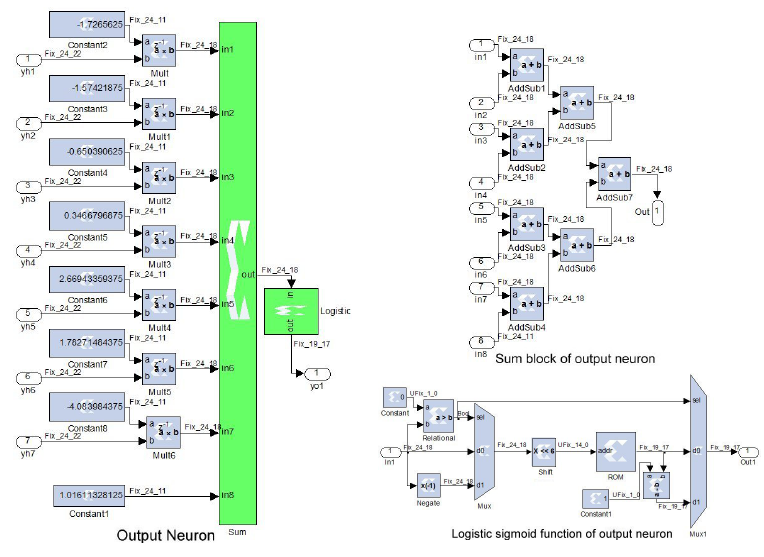
Figure 7. Implementation of the output neuron and its sum and logistic sigmoid blocks.